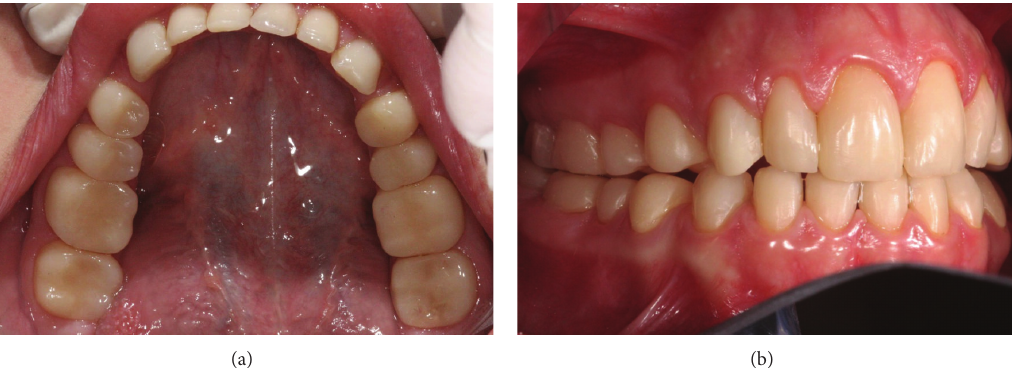
Figure 4: (a) Indirect and direct restorations in posterior and anterior lower teeth. (b) Final rehabilitation demonstrating aesthetic and functional result.